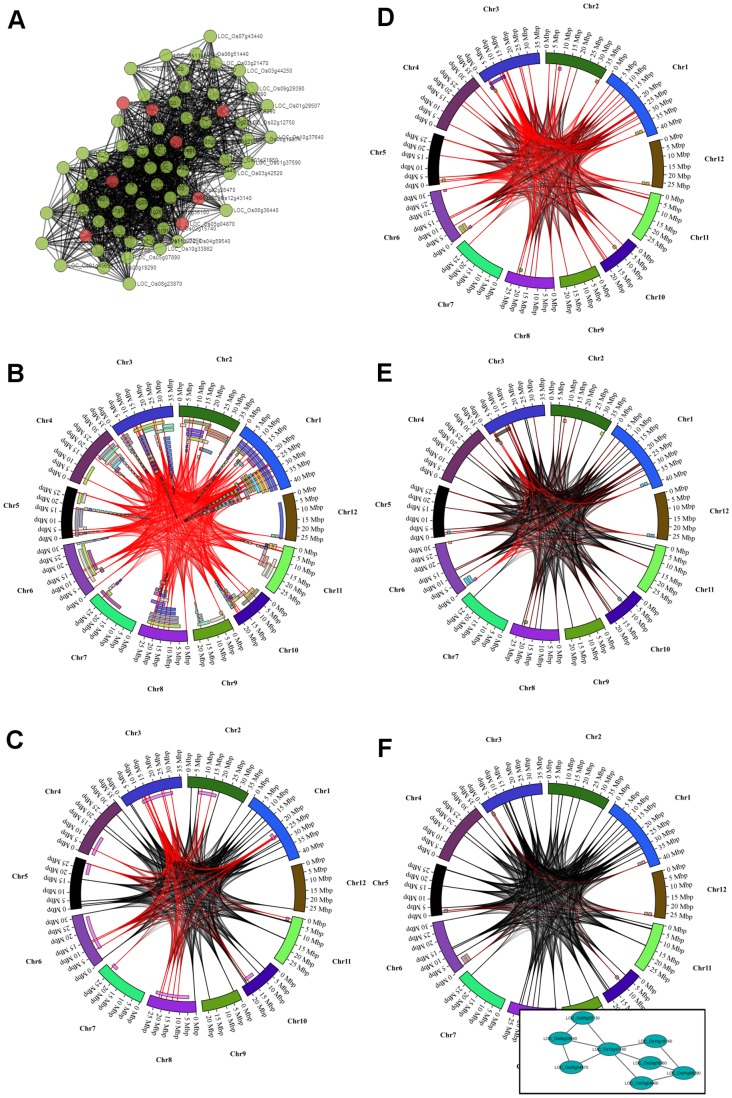
Circular Genome Plots of Network Module OsK25v1.0_G0002_LCM0431.The chromosomes of rice are shown as the outer circle. Gray arcs are edges of the module. Endpoints of each edge are fixed on the physical location in the genome where the node (gene) is found. Red arcs are edges that overlap a genetic feature. The colored tiles along the chromosomes represent genetic features (e.g. QTLs or regions around significant SNPs in GWAS). A) Network view of the module. Red nodes overlap with genetic traits for amylose content, green nodes do not. B) Circular plot of the module with all genetic features for plant height. C) Plot with QTLs from a single genetic map (Cornell 9024/LH422 RI QTL 1996) and edges highlighted red where an edge overlaps at least two QTL. D) Plot of the all genetic features for amylose content where edges overlap with at least 1 genetic feature. E) Plot of all genetic features for amylose content with overlap of at least 3 genetic features. F) Plot of module edges with QTLs from a single genetic map (CNHAU Zhen97/H94 QTL 2005) with overlap of at least 3 genetic features. The inset graph shows the connectivity of the overlapping nodes.